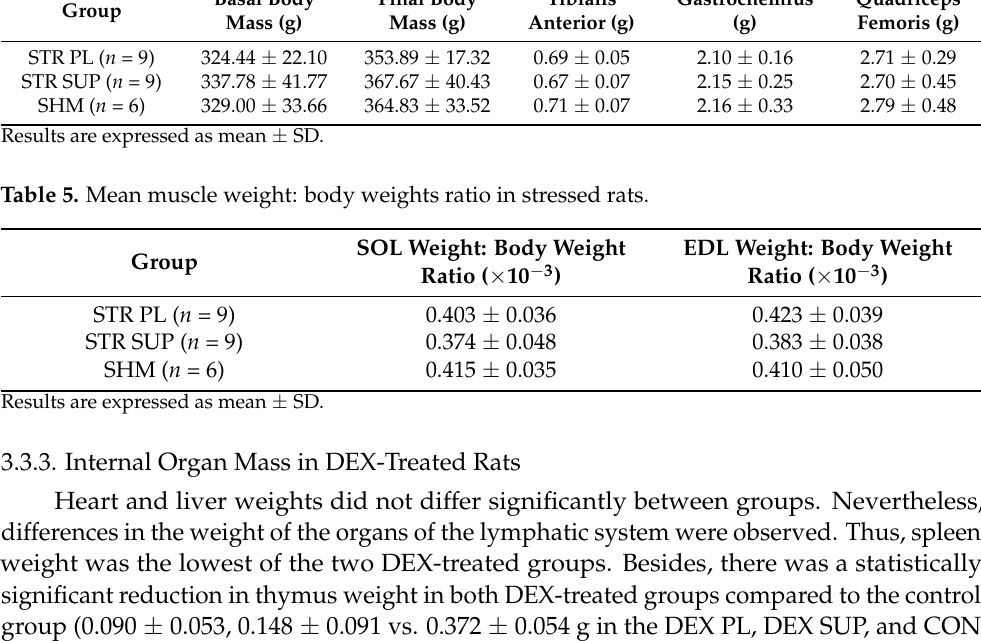
Table 4. Body and skeletal muscle mass at the end of the experiment in stressed rats. Basal Body Final Body Tibialis Gastrocnemius Quadriceps Group Mass (g) Mass (g) Anterior (g) (g) Femoris (g) STR PL ( n = 9) 324.44 ± 22.10